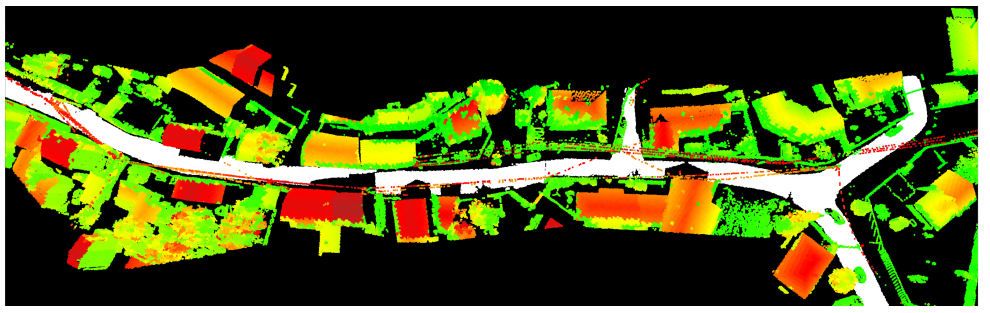
Figure 12. Height range, KNN =